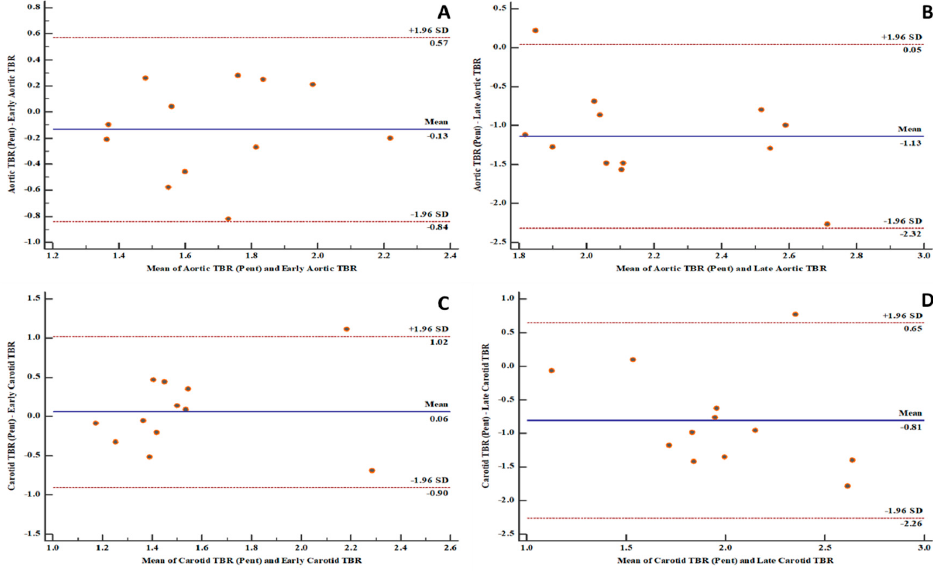
Figure 3. Bland and Altman plots showing good levels of agreement between fluorine-18 fluorodeoxyglucose positron emission tomography ([ 18 F]FDG PET) and gallium-68 pentixafor positron emission tomography ([ 68 Ga]Ga-pentixafor PET)-derived variables: ( A ) a good level of agreement between [ 68 Ga]Ga-pentixafor PET-derived aortic target-to-background ratio (TBR) and [ 18 F]FDG PET-derived early aortic target-to-background ratio (TBR) with 91.7% of measurements within the limits of agreement; ( B ) a good level of agreement between [ 68 Ga]Ga-pentixafor PET-derived aortic target-to-background ratio (TBR) and [ 18 F]FDG PET-derived late aortic target-to-background ratio (TBR) with 91.7% of measurements within the limits of agreement; ( C ) a good level of agreement between [ 68 Ga]Ga-pentixafor PET-derived carotid target-to-background ratio (TBR) and [ 18 F]FDG PET-derived early carotid target-to-background ratio (TBR) with 91.7% of measurements within the limits of agreement; ( D ) a good level of agreement between [ 68 Ga]Ga-pentixafor PET-derived carotid target-to-background ratio (TBR) and [ 18 F]FDG PET-derived late carotid target-to-background ratio (TBR) with 91.7% of measurements within the limits of